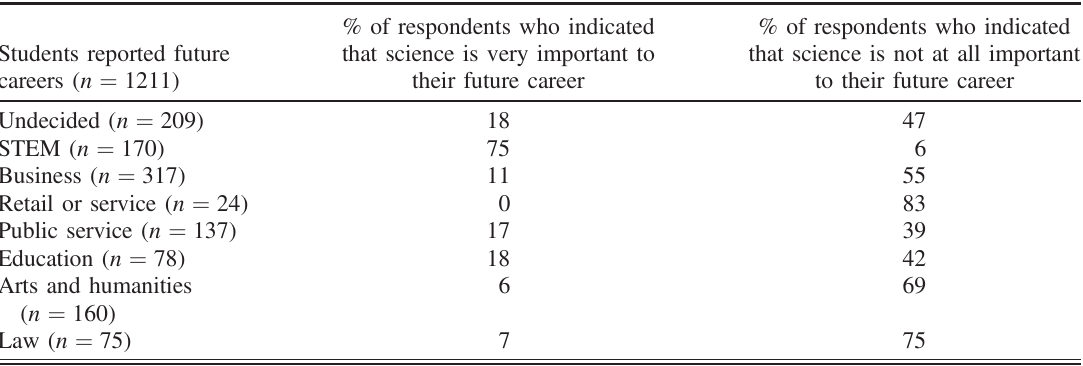
TABLE X. The relationship between students ’ future plans and the importance of science to their future career. Students reported